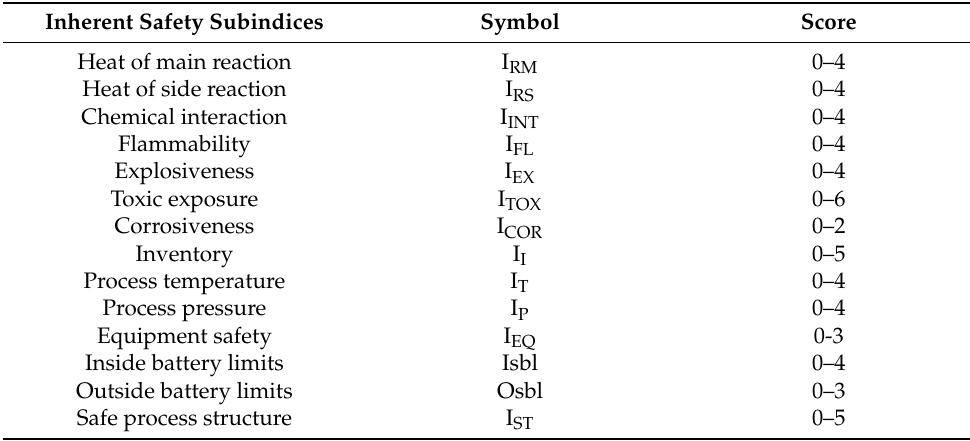
Table 1. Symbols and scores for inherent safety